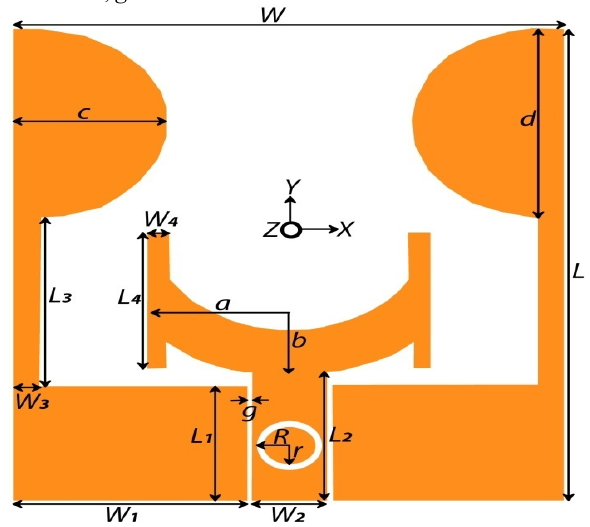
FIGURE 1. Front view and dimensions of the U-shaped CPW-fed antenna.